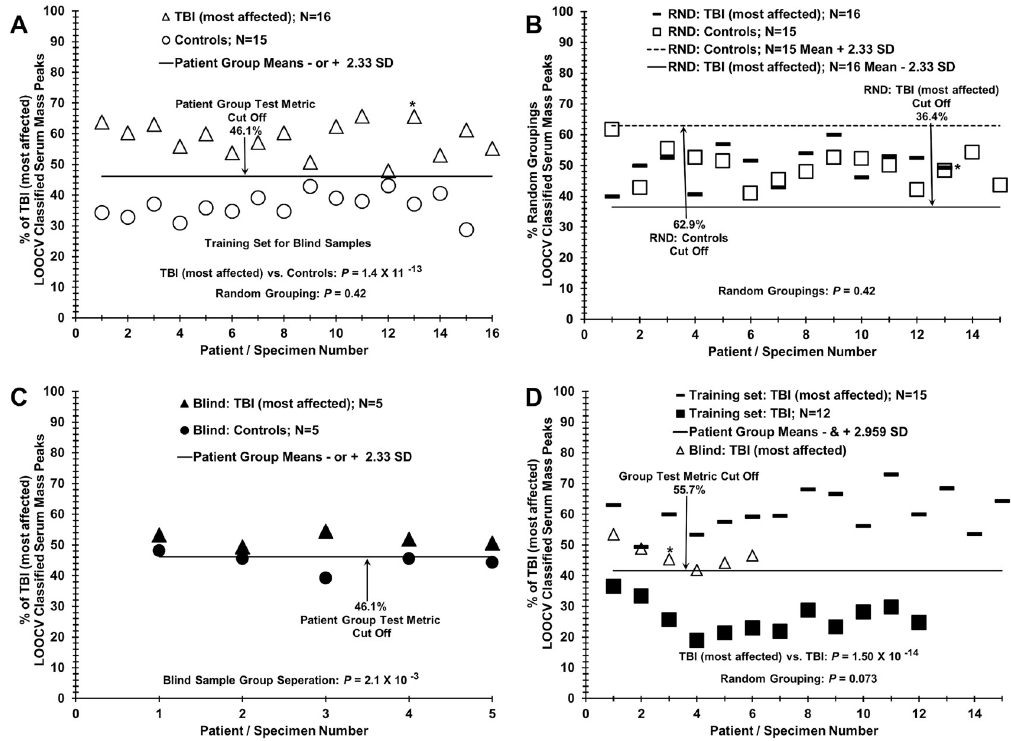
Fig 4. Analysis of blinded sera samples: Comparing patients with TBI+PCS versus controls or TBI alone. (A)Training set of serum discrimination of TBI most affected patients (triangles) from controls (circles) by % of LOOCV classified mass peaks; correct true positives and true negatives are observed. (B) Non-serum sample discrimination observed when the two different sample groups in panel A are mixed together randomly followed by the same LOOCV mass peak analysis. (C) Assessing the ability of the training set in panel A to correctly discriminate a blinded group of ten samples; 9 out of 10 samples were correctly identified. (D) Discrimination of sera from TBI most affected patients (dashes) from patients with TBI alone (dark squares), and assessment of 6 “left out” group of TBI most affected patients (triangles); 5 out of 6 blinded most affect patients were identified. An � indicates a female volunteer and no experimental segregation is observed from the male volunteers in this